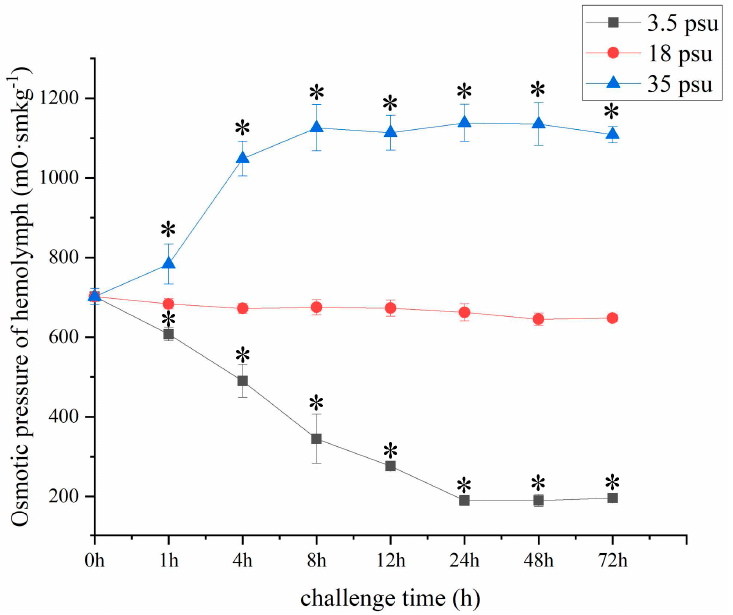
Figure 7. Osmotic pressure changes in S. constricta post-exposure to the low- and high-salinity environment. Vertical bars represent the mean ± SE ( n = 5). Data were statistically analyzed by using one-way ANOVA, followed by the LSD test. The asterisks (*) show a significant difference between the experimental group (low- and high-salinity group) and the control group at each sampling time. Note: * p < 0.05.